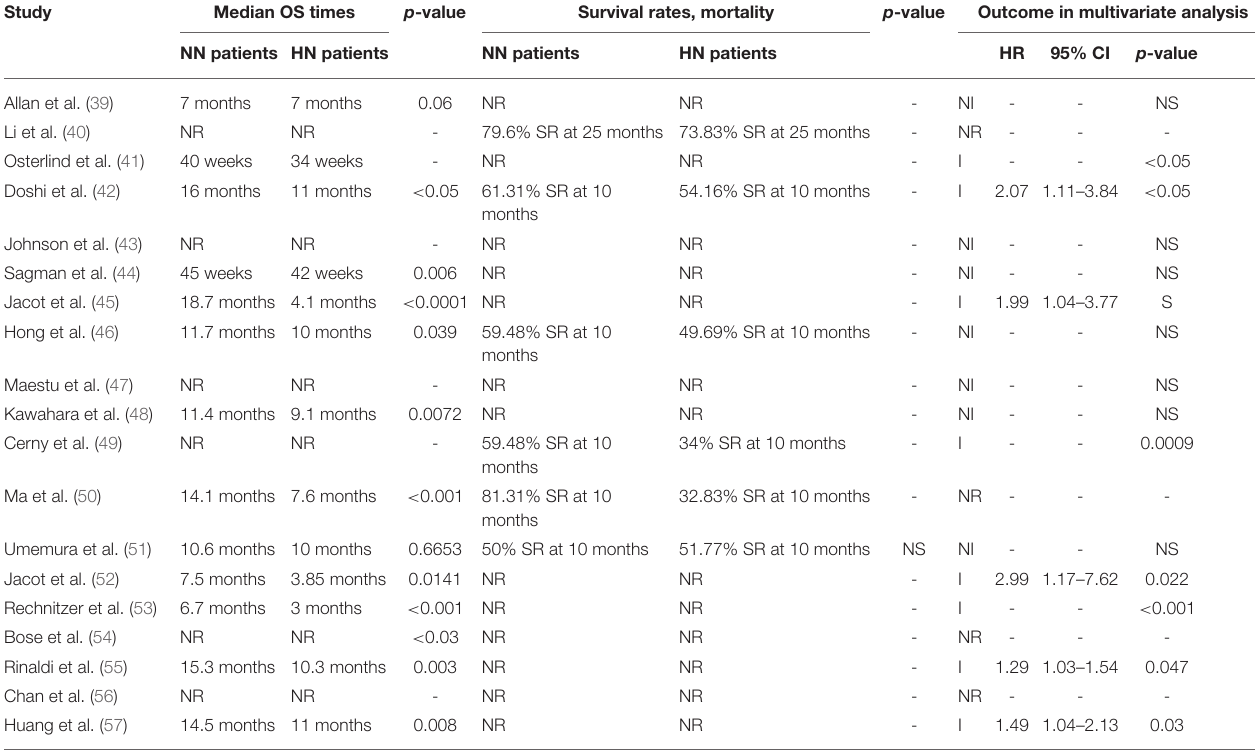
TABLE 3B | The outcomes in lung cancer patients among the included